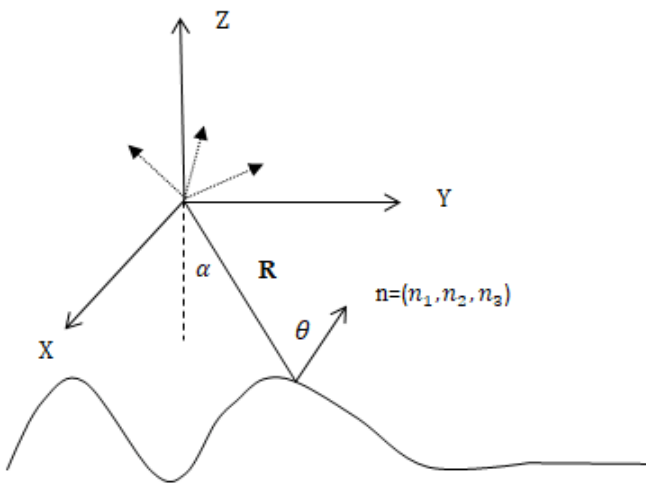
Figure 1. Diagram of incident angle and